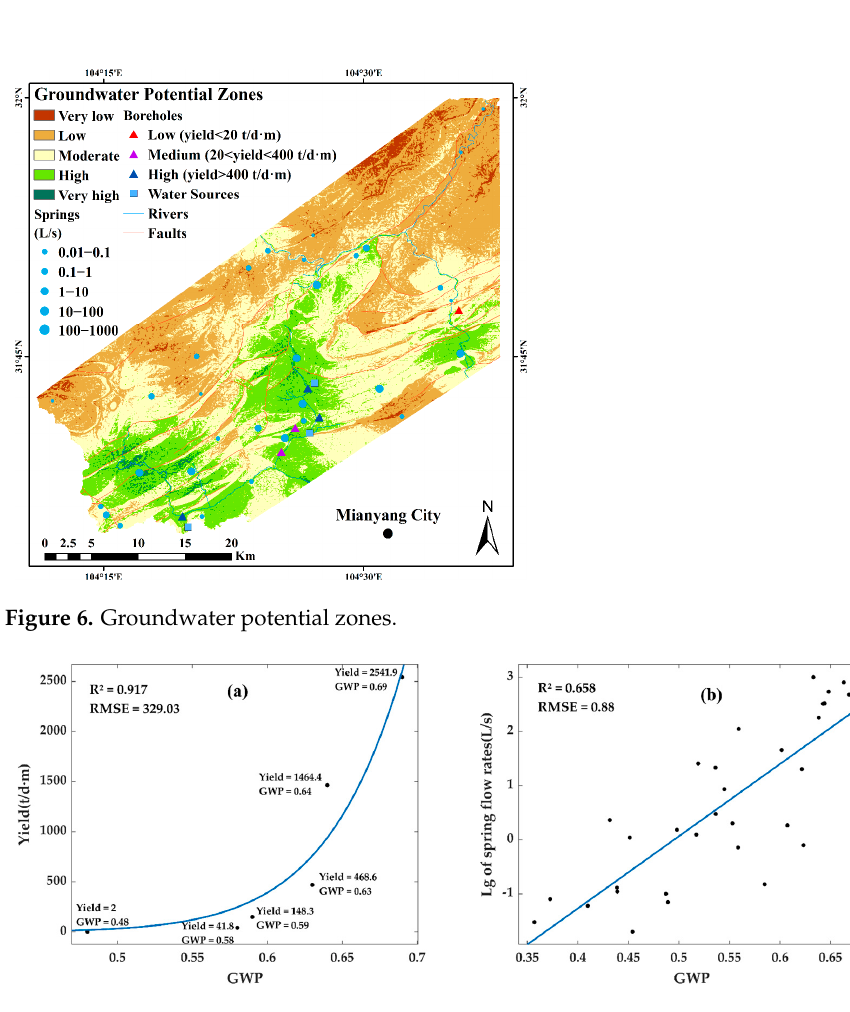
Figure 7. Regression of actual data and GWP: ( a ) regression of borehole yield rate and GWP, ( b ) regression of the logarithm of spring flow rates and GWP.